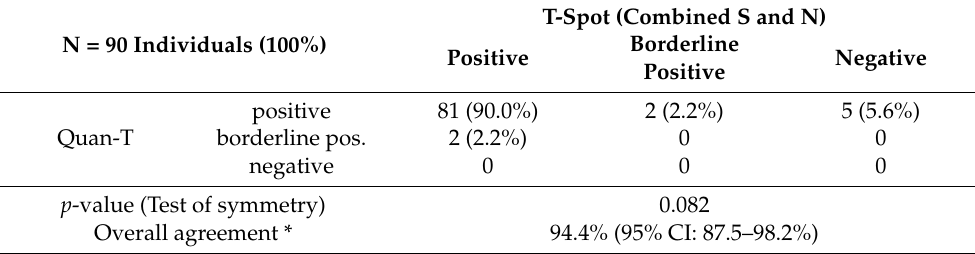
Table 1. Qualitative comparison between results obtained using T-Spot and Quan-T IFN- γ release